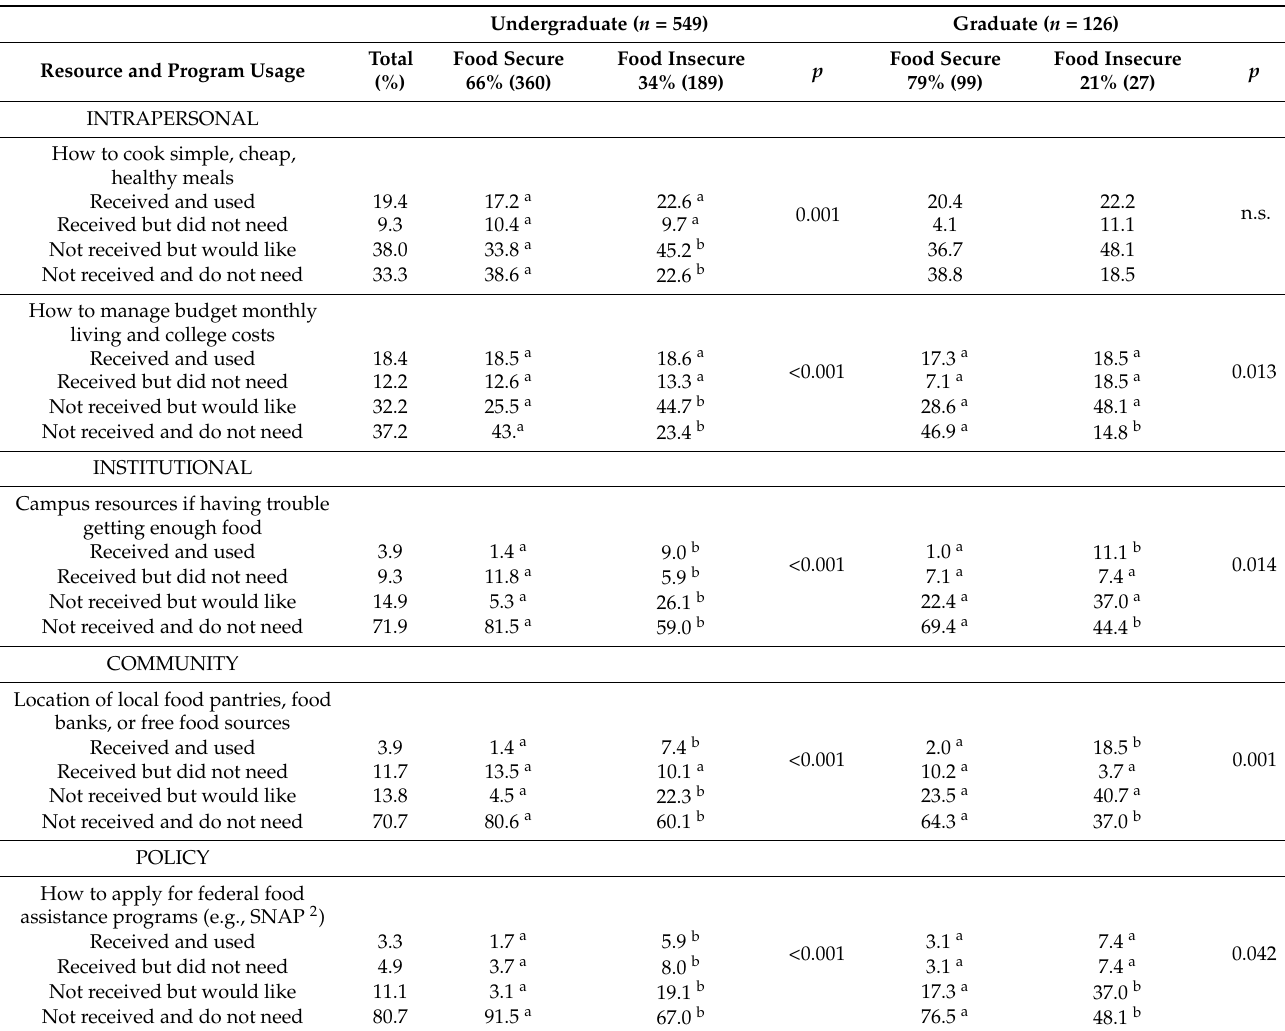
Table 4. Resource and food assistance program usage by midwest university students by academic and food security status 1 .